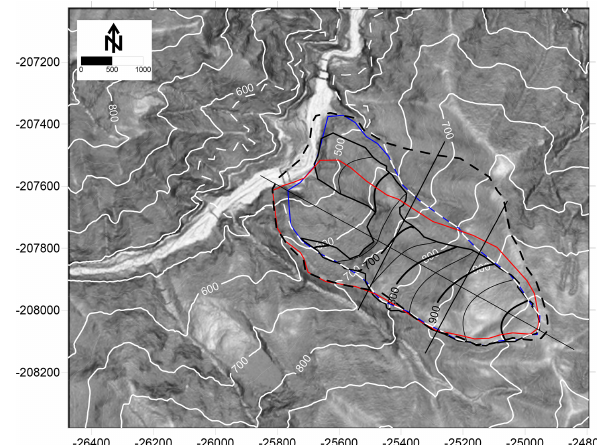
Figure 16. Slope angle map of the Akatani landslide area from the 1m pre-DEM, displaying the reconstruction of the pre-topography (in black) compared to the pre-DEM (in